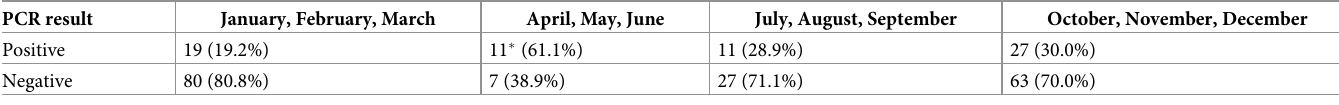
Table 5. Higher detection rate of S . calchasi DNA in the second quarter of the year.